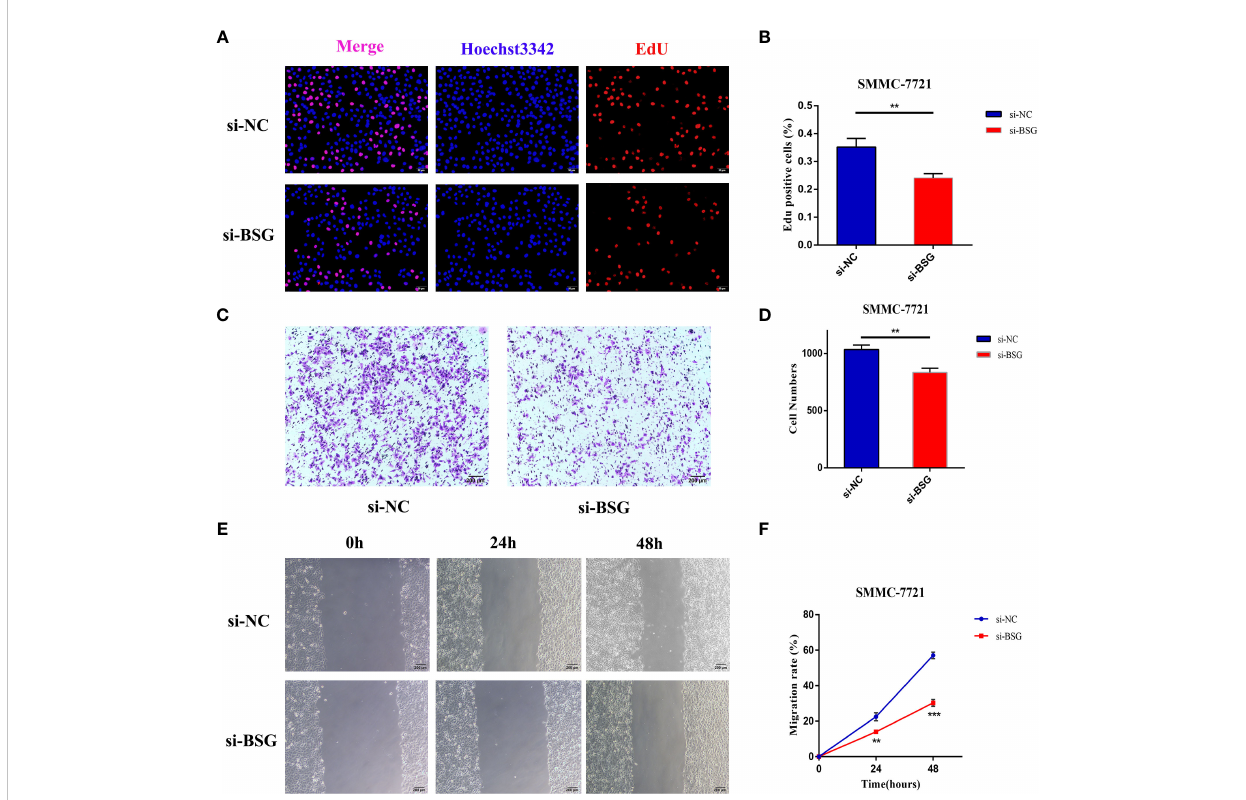
FIGURE 12 The expression level of BSG is related to the poor prognosis of HCC. (A, B) EdU assay showed that the cell proliferation rate of si-BSG group was signi fi cantly lower than that of si-NC group. (C, D) Transwell assay showed that inhibiting the expression of BSG could signi fi cantly inhibit the migration ability of HCC cells. (E, F) The wound healing assay showed that the migration ability of HCC cells were signi fi cantly inhibited after the intervention of BSG expression. **<0.01, ***